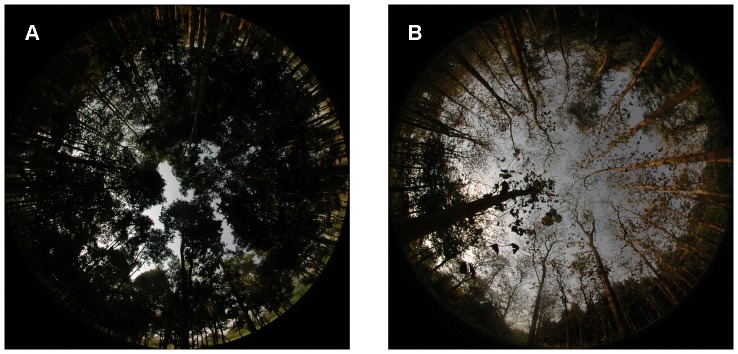
Hemispherical photographs with high and low amounts of mixed pixels.Histogram-exposed photographs of site V (A) with foliated vegetation and a low amount of mixed pixels and site VIII (B) with defoliated vegetation and a high amount of mixed pixels.